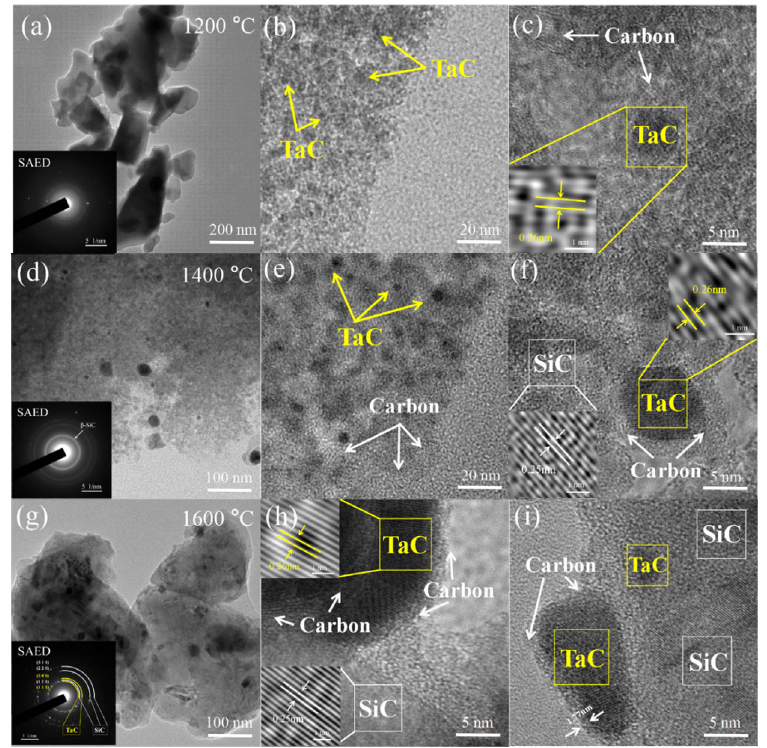
Table 1 Chemical composition of resultant ceramics annealed at different temperatures annealing